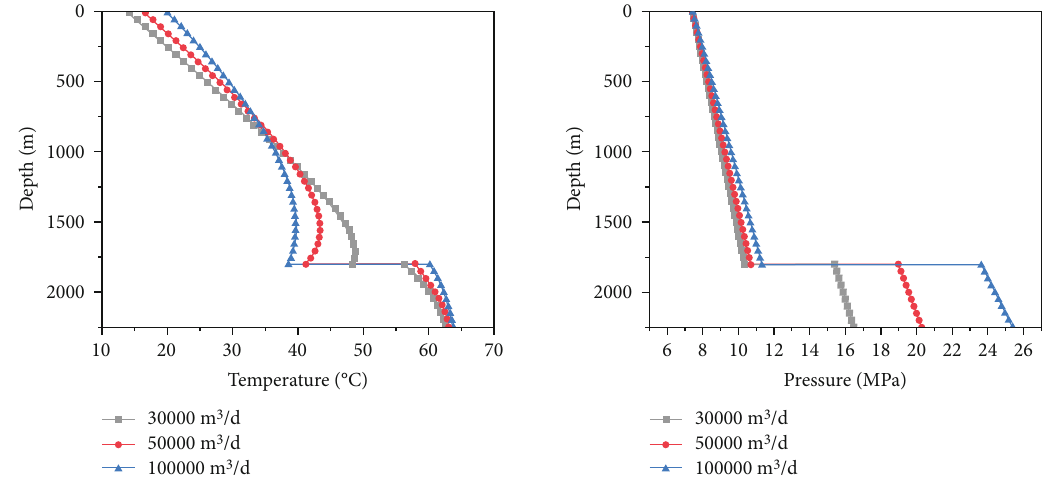
Figure 9: E ff ect of gas production on throttling temperature and pressure